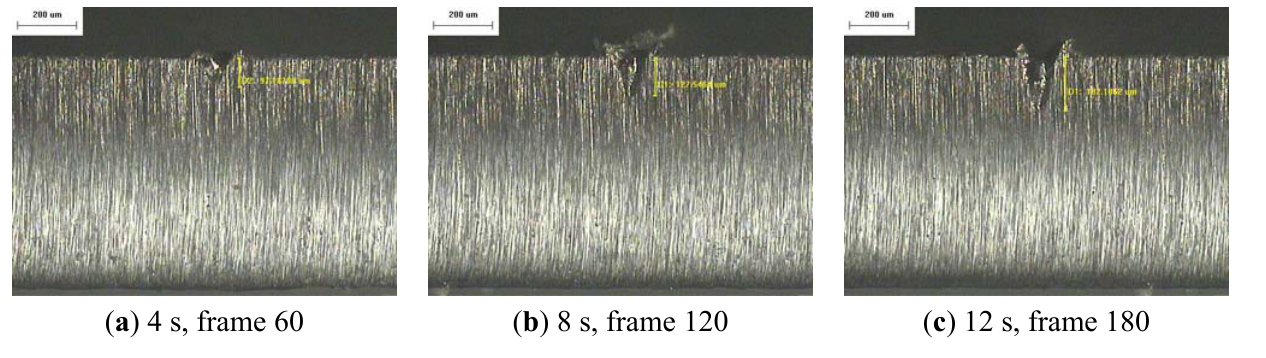
Figure 8. Workpiece (SS 420) profile images at different process times (radiation energy is 145 mJ): ( a – h )